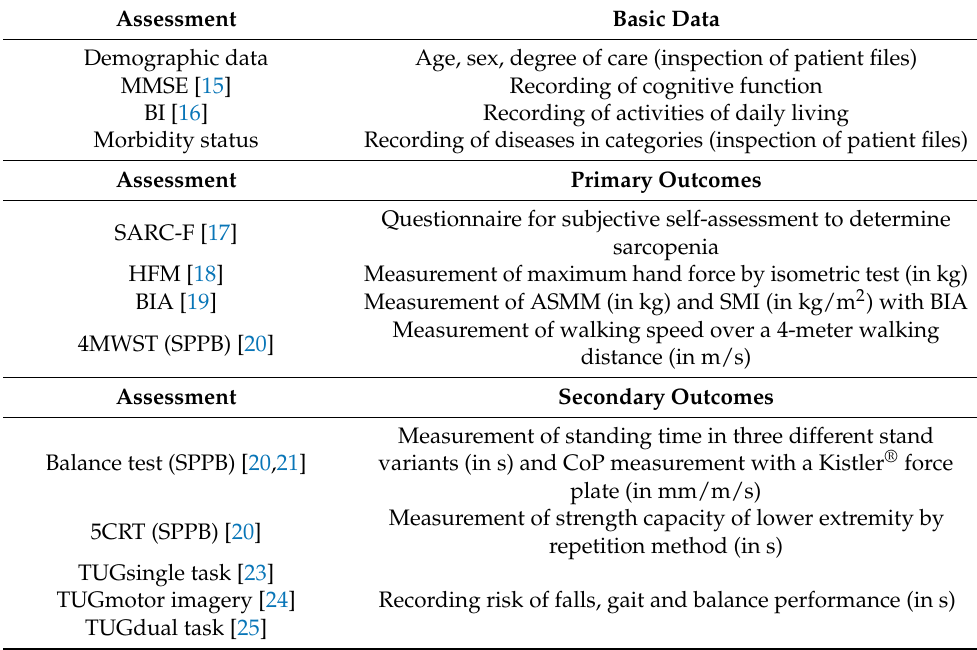
Figure 1. Algorithm for quantification of sarcopenia according to EWGSOP2 (modified after [7]). Table 1. Overview of the geriatric assessment in the BaSAlt